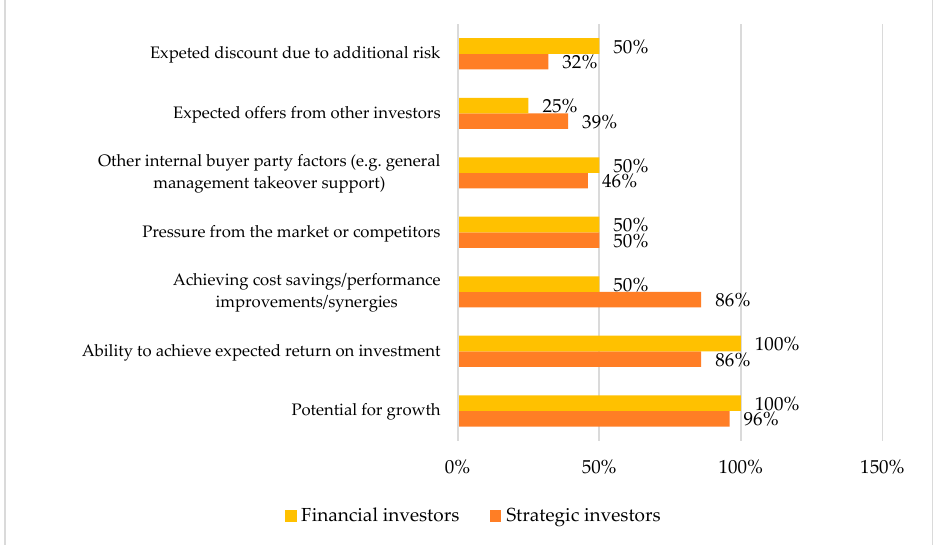
Figure 3. Motives for mergers and acquisitions by two groups of investors—financial and strategic. Source: authors’ own studies, developed from [50].